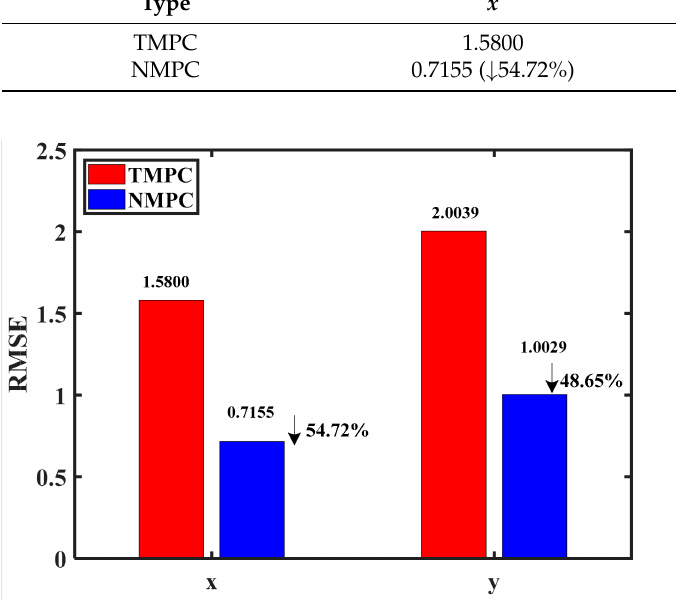
Figure 16. The histogram comparisons of two MPC controllers under the ITR.